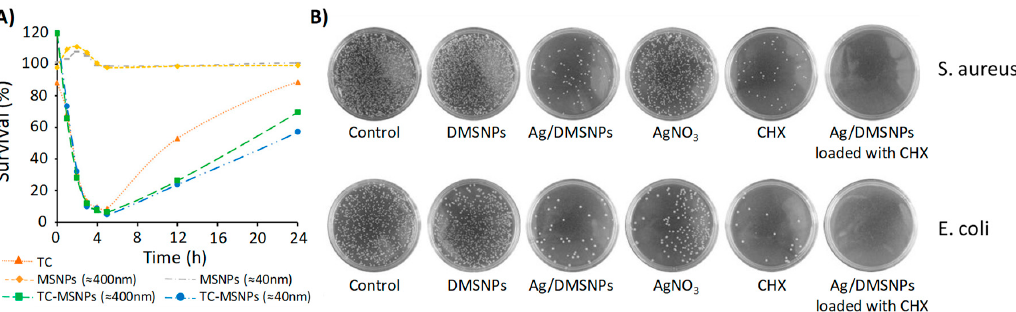
Figure 3. ( A ) Survival (%) of E. coli treated with a concentration: 1.0 µg/mL of tetracycline (TC) or its equivalent in loaded MSNPs (adapted with permission from [67], copyright MDPI 2015). ( B ) Photographs of Luria-Bertani (LB)-agar plates coated with S. aureus (up) and E. coli (below) when supplemented with Ag/dendritic mesoporous silica nanoparticles (DMSNPs) loaded with CHX, CHX, AgNO 3 , Ag/DMSNPs, and DMSNPs, respectively (adapted with permission from [68], copyright Dovepress 2017).